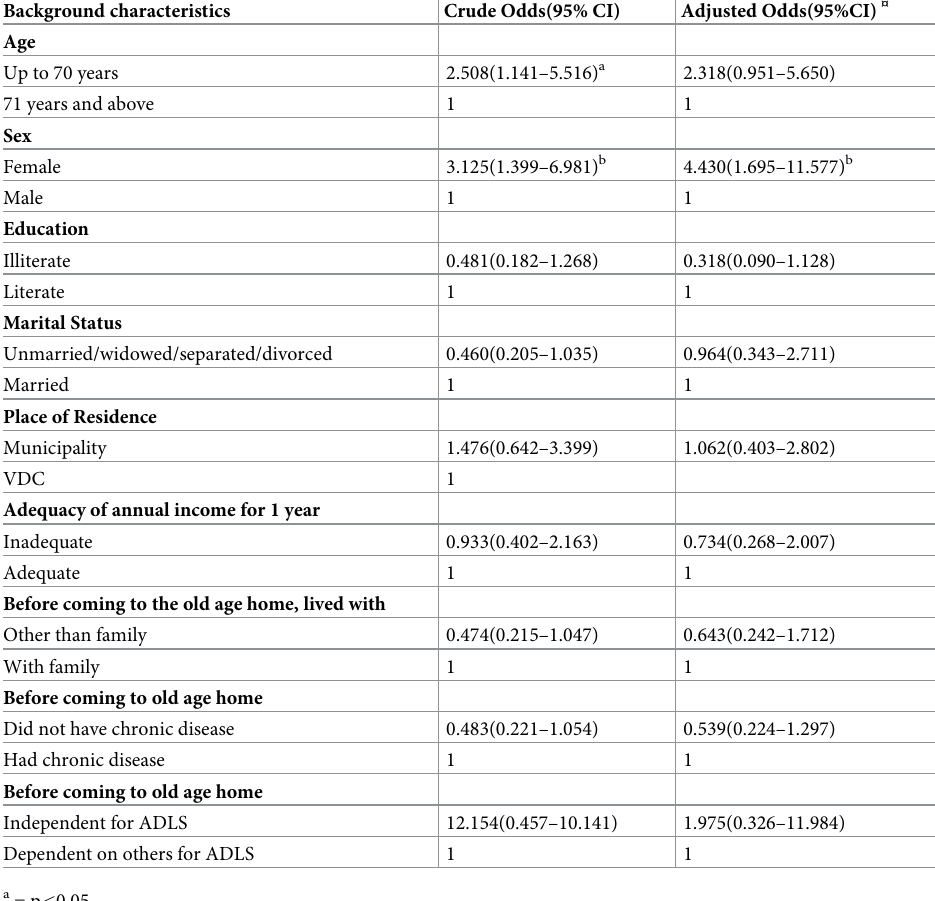
Table 6. Factors associated with abuse of older adults transferred to old age homes (n = 109). Background